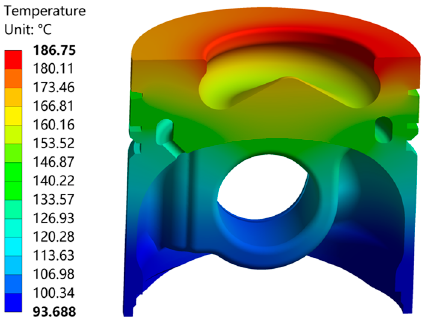
Figure 13. Temperature field of conventional Al-Si piston under 25% load.